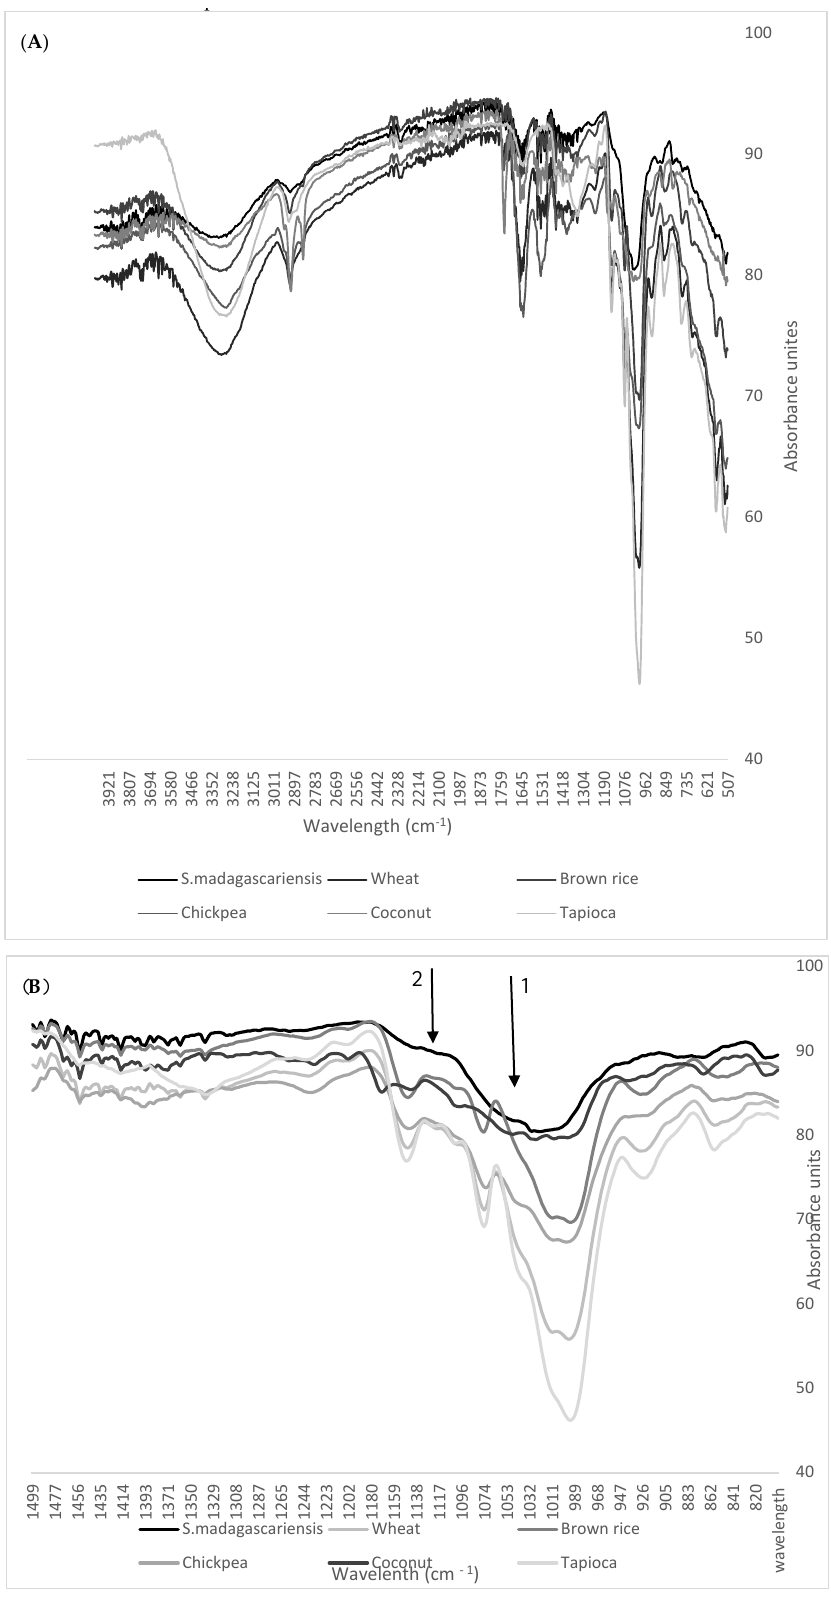
Figure 3. ( A ) Superimposed FTIR spectra of the S. madagascariensis seed flour and the reference flours (wheat, brown rice, chickpea, coconut and tapioca), and ( B ) the region where the differences are observed in the S. madagascariensis seed flour.